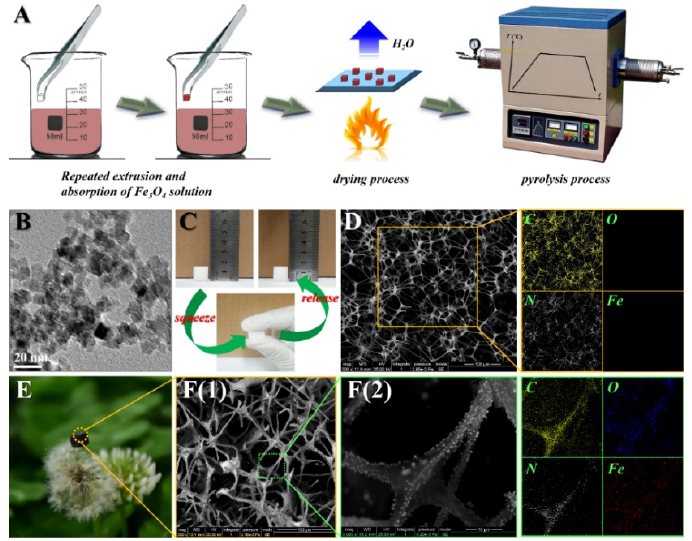
Figure 1. ( A ) Schematic of magnetic graphite-like C 3 N 4 /carbon foam (MCMF) preparation. ( B ) TEM image of Fe 3 O 4 nanoparticles. ( C ) Physical images of elasticity test. ( D ) SEM image of carbonized melamine formaldehyde (MF) foam without Fe 3 O 4 (CMF) along with the C, O, N and Fe elemental EDS mapping images. ( E ) Practical image of MCMF. ( F ) SEM images of MCMF along with the corresponding C, O, N and Fe elemental EDS mapping images.